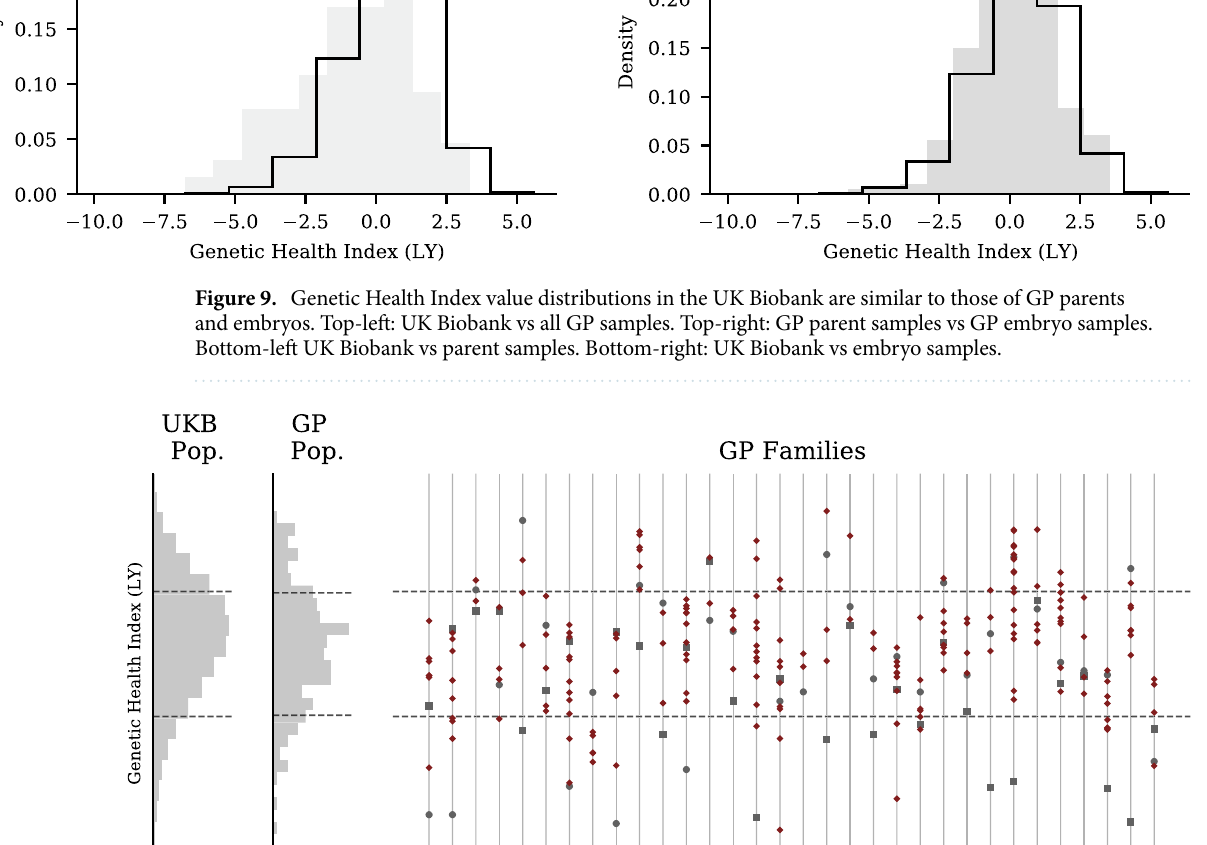
Figure 10. Genetic Health Index for GP/IVF families (uncentered). Far left histogram describes UKB general population. Middle histogram describes GP IVF embryos in aggregate (note this is a mixture of highly-related (sibs) (sibs from different families). Individual families are displayed on the right with mother represented by a circle and father by a square. Note siblings can have higher or lower Index than either